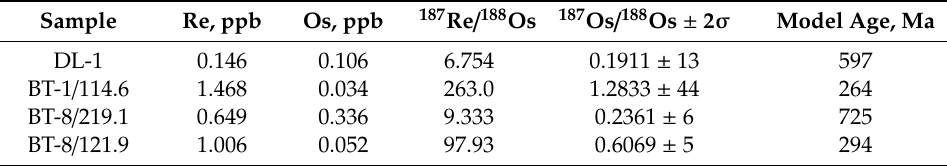
Table 3. Re–Os isotope data for the Turumakit